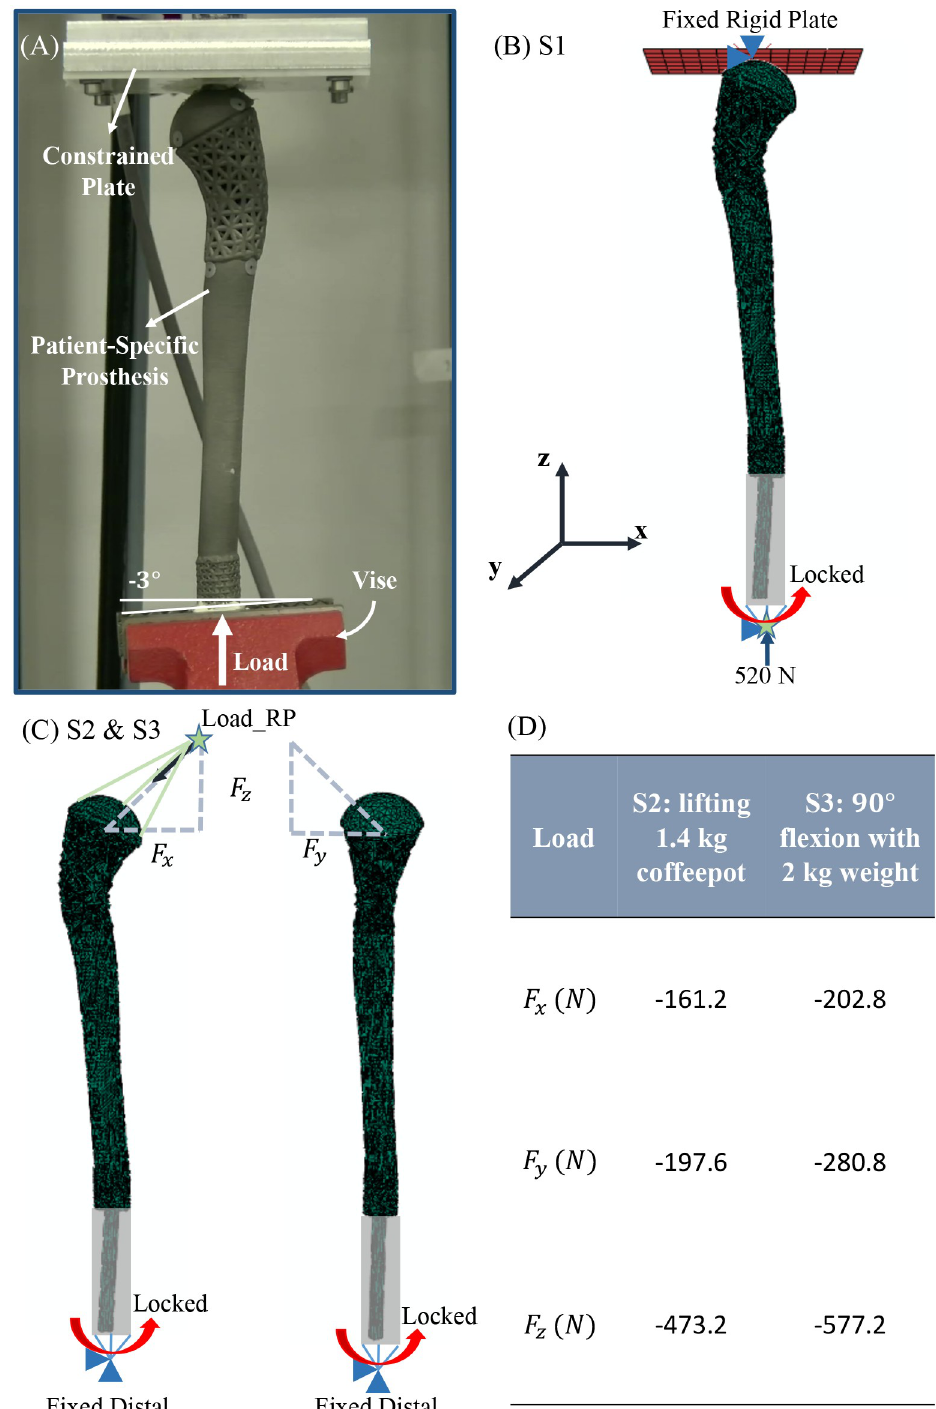
Fig 3. (A) Biomechanical testing (cyclic loading) of AM prosthesis for tumor reconstruction. (B-D) Applied boundary conditions in the FEA models; the grey region indicates where the stem (green) was fixed to a reference point at the bottom of the images; (B) S1 which mimics the previously established biomechanical test setup, and (C-D) S2 and S3 boundary conditions with applied multi—directional joint reaction forces [33] based on the previous in-vivo study.